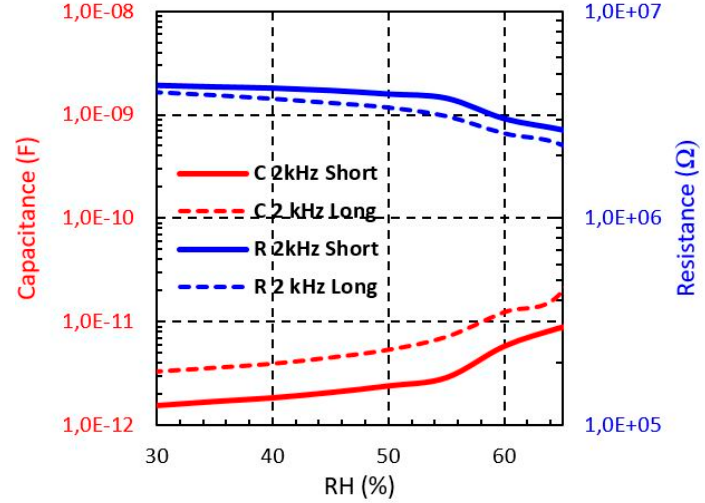
Sensors 2019 , 19 , x FOR PEER REVIEW 8 of 10 Figure 8. Measured Shieldex sensors impedance from 30% to 65% RH at different frequencies.